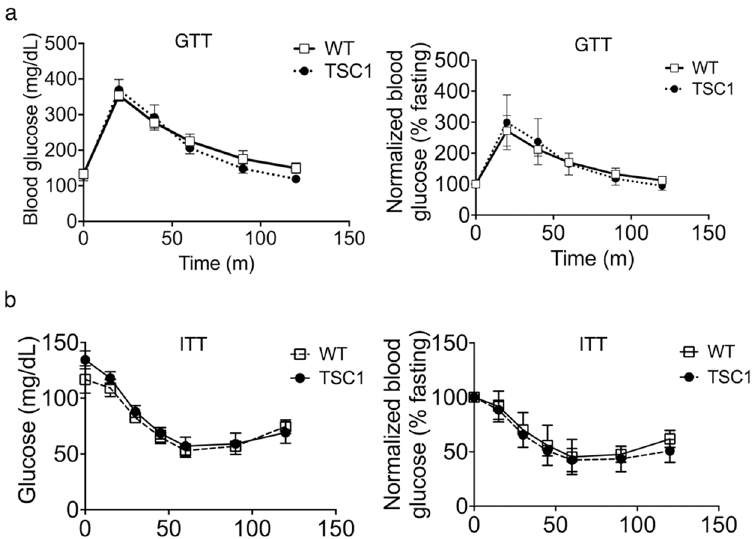
Figure 5. Glucose tolerance and insulin sensitivity in TSC1 tg mice. ( a ) Glucose tolerance test (GTT) in 22–24 month old female mice (n = 6 mice in each group). ( b ) Insulin sensitivity test (ITT) in female 22–24 month old mice (n = 6 mice in each group). Blood glucose was measured every 15 or 30 minutes after either glucose or insulin injection. The left graphs corresponding to each graph on the left are plotted after normalizing to the levels of blood glucose just prior to the injection. WT – wild type mice (white square); TSC1 - TSC1 tg mice (Solid black